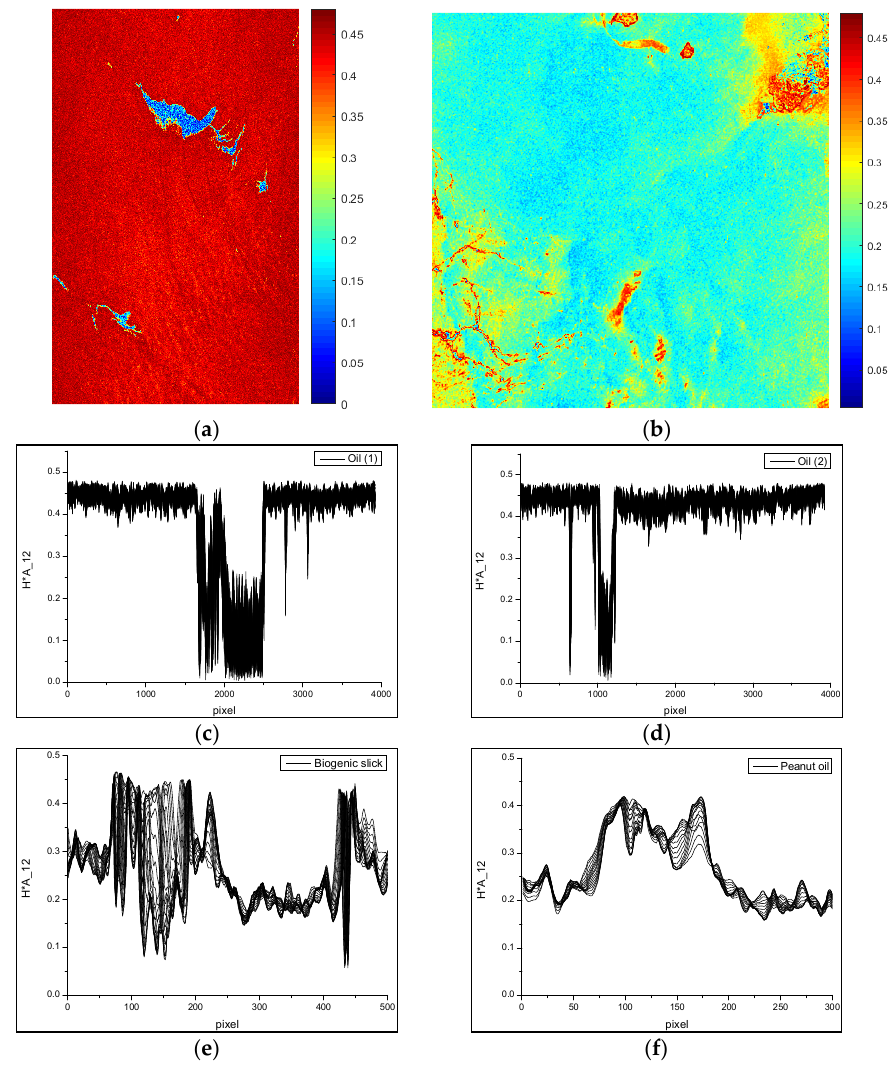
Figure 9. H * A 12 value for the two continuously slow-release slicks cases mentioned above: ( a ) Case 1; ( b ) Case 2; ( c – f ) the modified H * A 12 for the four green rectangular areas (oil (1), oil (2), biogenic slick, and peanut oil, respectively) that are indicated on the SAR images in Figures 2 and 3.